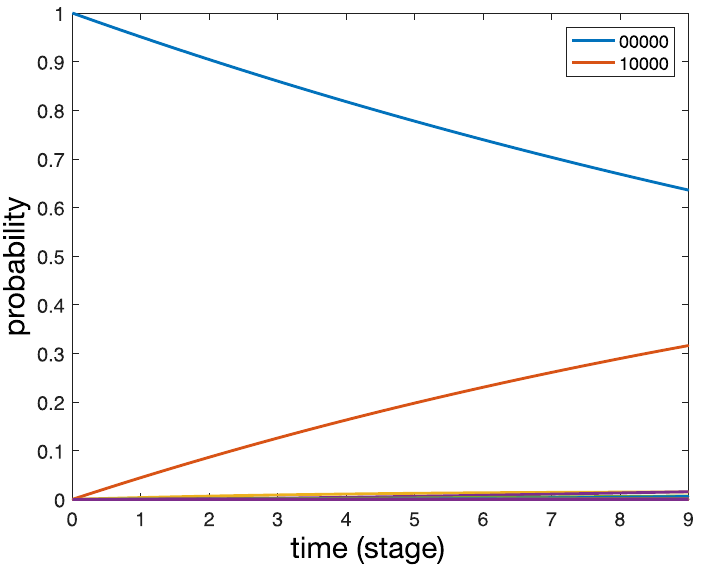
Fig 8. A solution to Eq (4) with parameter values obtained from the maximum likelihood method. Each curve correspond to specific state of the system.